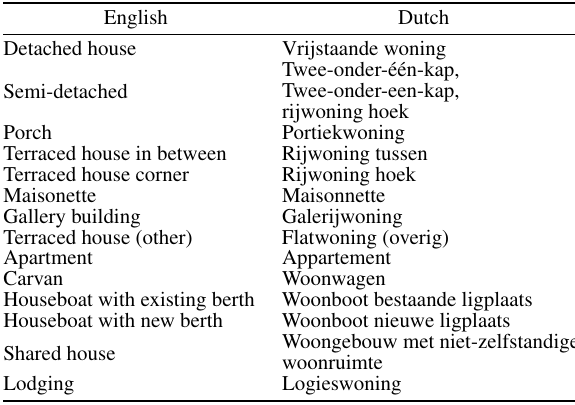
Table 4. Netherlands classification of the building